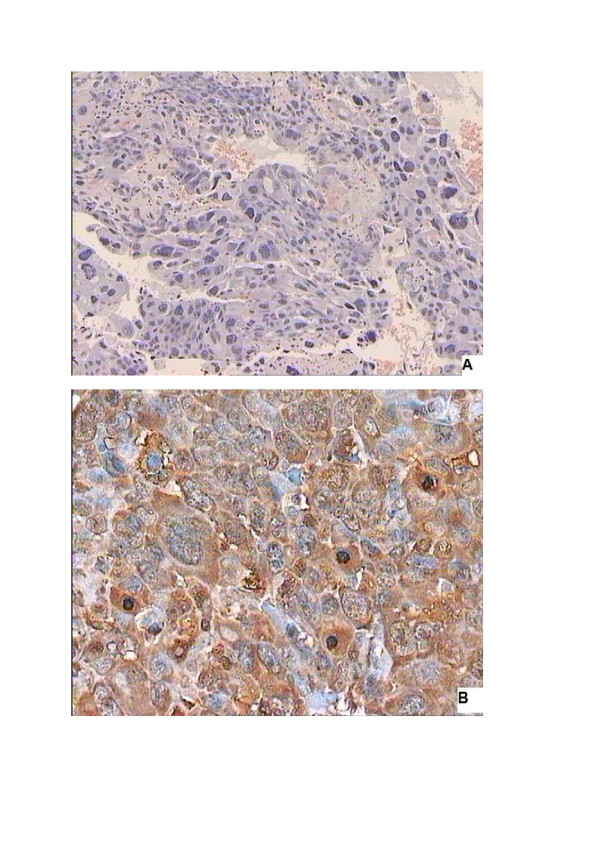
A. Mediastinal choriocarcinoma: Diffuse sheets of cytotrophblastic and syncytiotrophoblastic cells. Hemorrhagic and necrotic locations are also seen. (medium power magnification) B. Tumor cells with diffuse positive cytoplasmic immunostaining for β-hCG.(High power magnification).